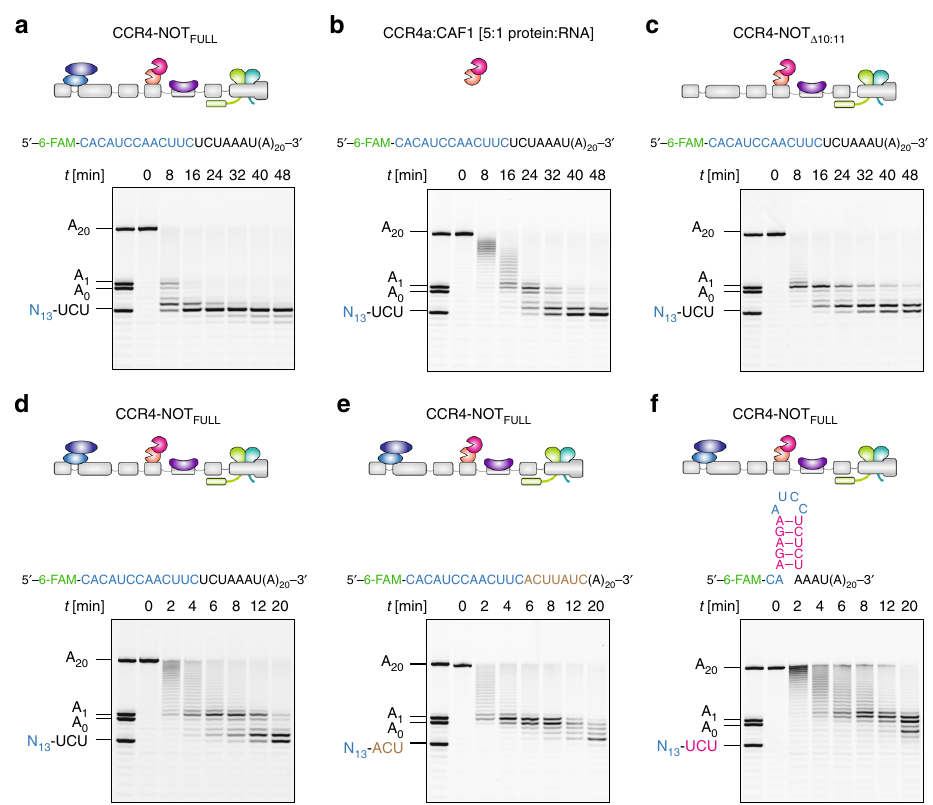
Fig. 6 The length of the segment preceding the poly(A) tail but not its sequence impacts on deadenylation. a Deadenylation assay with the CCR4-NOT FULL complex and the 13 + 7-mer-A 20 RNA substrate in equimolar ratio (50 nM). This substrate contains an additional unstructured 13-mer segment 5 ′ to the 7- mer-A 20 RNA. The deadenylation of this substrate is markedly enhanced compared to the 7-mer-A 20 substrate (Fig. 2d) and did not proceed beyond the fi rst two consecutive non-A nucleotides. b Deadenylation assay with the same 13 + 7-mer-A fi ve-fold molar excess of the 20 substrate (50 nM) and a CCR4a:CAF1 exonuclease heterodimer (250 nM). The rate of deadenylation does not differ to that with the 7-mer-A 20 substrate indicating that the exonuclease heterodimer does not discriminate between these substrates (Fig. 2c). c Deadenylation assay with the CCR4-NOT Δ 10:11 complex and the 13 + 7-mer-A 20 RNA substrate in equimolar ratio (50 nM). d Deadenylation assay with the CCR4-NOT FULL complex and the 13 + 7-mer-A 20 substrate (both 50 nM) with higher resolution of the early time points compared to a . e Deadenylation assay with the CCR4-NOT FULL complex and a 20-mer-A 20 substrate where the seven nucleotides immediately preceding the poly(A) tail were different from the 13 + 7-mer-A 20 substrate in equimolar ratio (50 nM). f Deadenylation assay with the CCR4-NOT FULL complex and the 13-SL-7-mer-A 20 substrate containing a short stem-loop structure within the 20- nucleotide region upstream of A 20 in equimolar ratio (50 nM) (see also Supplementary Table 4). Source data are provided as a Source Data fi